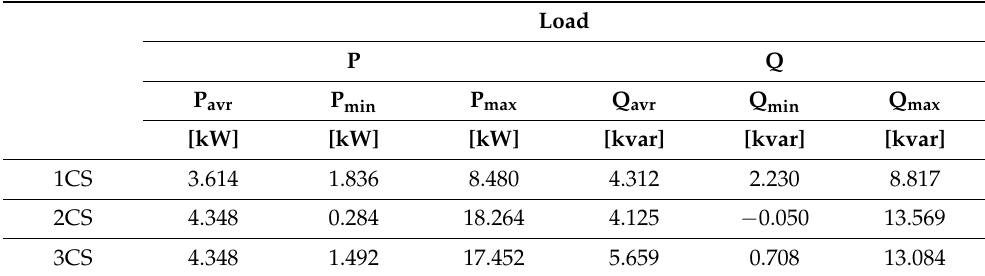
Table 5. Average, minimum, and maximum loads of active and reactive power in each stage of the